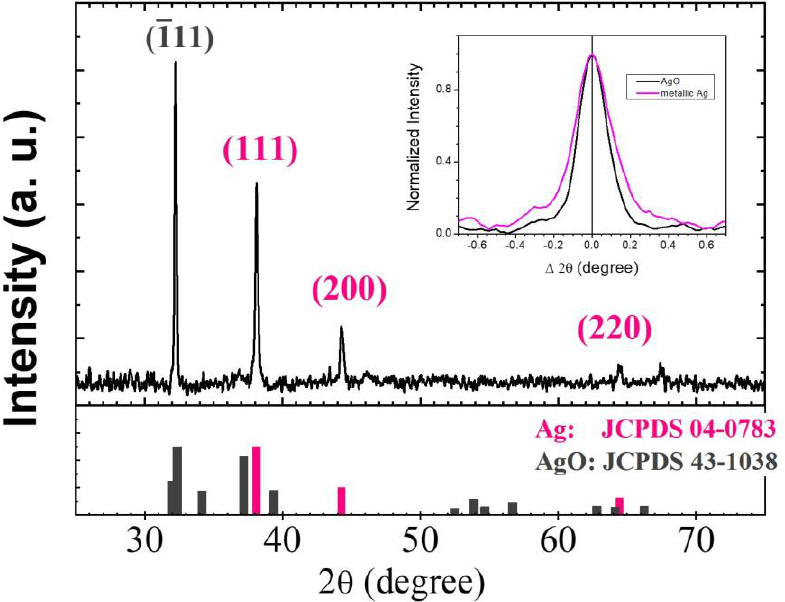
Figure 2. X-ray diffraction exhibits polycrystalline metallic Ag and high texturized AgO phases—the inset attests to the higher crystallinity of the AgO phase.